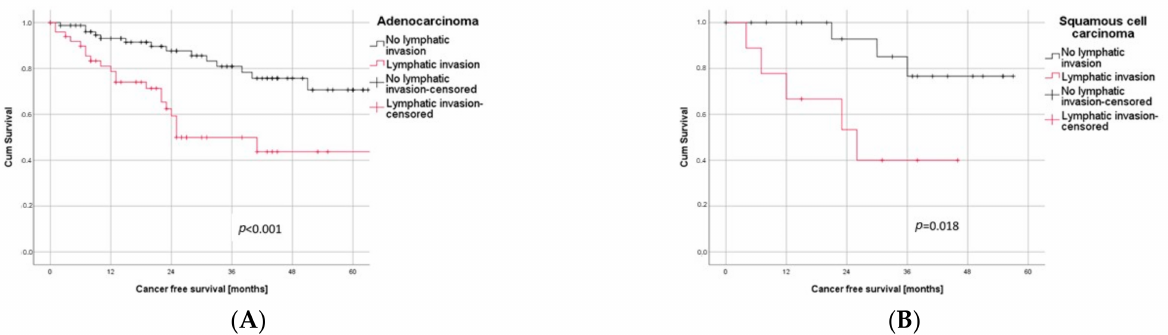
Figure 3. Subgroup Analysis. ( A ) Patients with adenocarcinoma and LVI had a significantly worse outcome than those without LVI (log rank test: p < 0.001). ( B ) In patients with squamous cell carcinoma, LVI significantly correlated with negative outcome (log rank test: p =